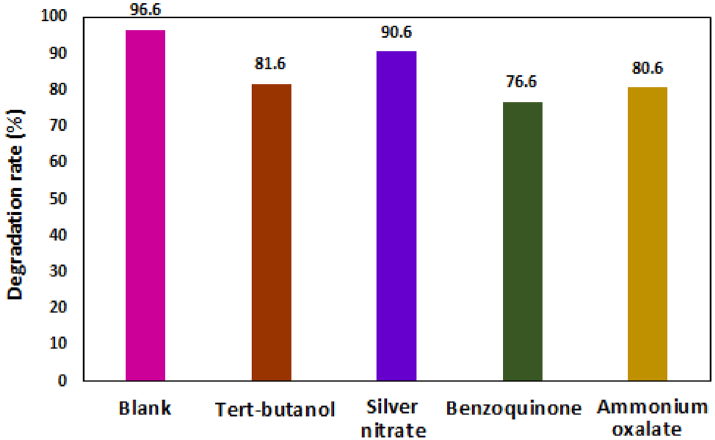
Figure 14. Effect of various scavengers on the photocatalytic degradation of MB in the presence of high- pressure mercury